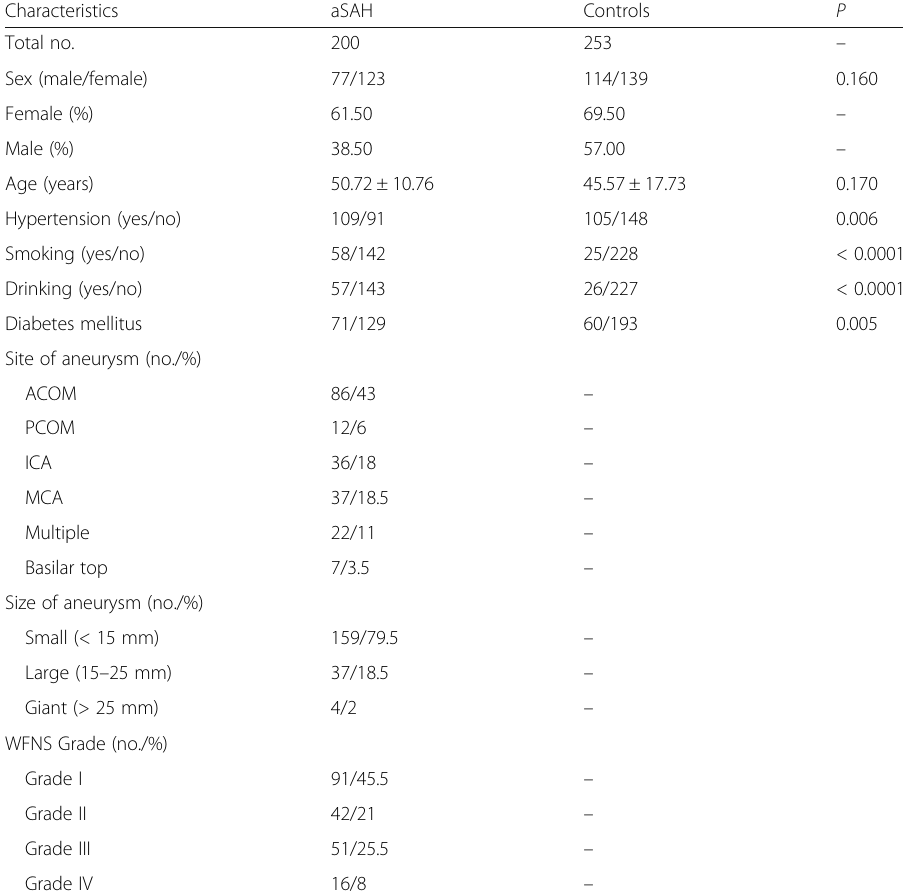
Table 1 Demographic and clinical characteristics of patients with aSAH and healthy controls Characteristics aSAH Controls